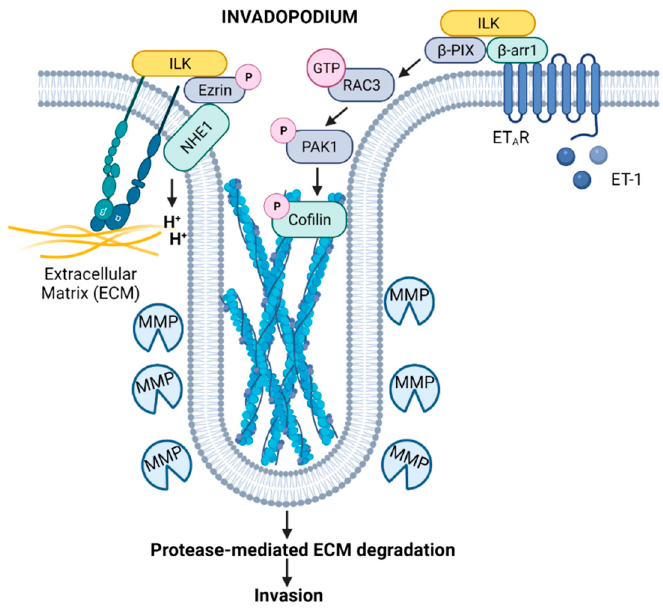
Figure 2. Model depicting the contributions of ILK signaling to the function of invadopodia. Integrin-induced activation of ILK drives NHE1-mediated scaffolding and acidification functions through an ILK/p-ezrin/NHE1 complex [25], while ET-1-mediated activation of a β -arr1/ILK/ β -PIX platform leads to Rac activation and phosphorylation of cofilin [24], promoting invadopodium-dependent ECM proteolysis and degradation. These ILK signaling platforms may potentially cooperate to expedite ECM degradation and invasion by cancer cells. Created with Biorender.com. Available online: https://biorender.com/ (accessed on 2 June 2022).